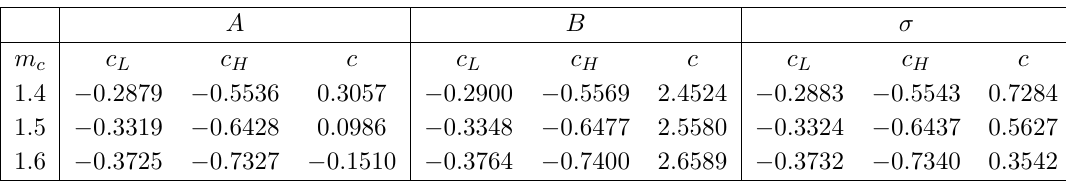
Table 3 . The coefficients c L , c H , and c for e + e − → J/ψ + χ c 1 at is